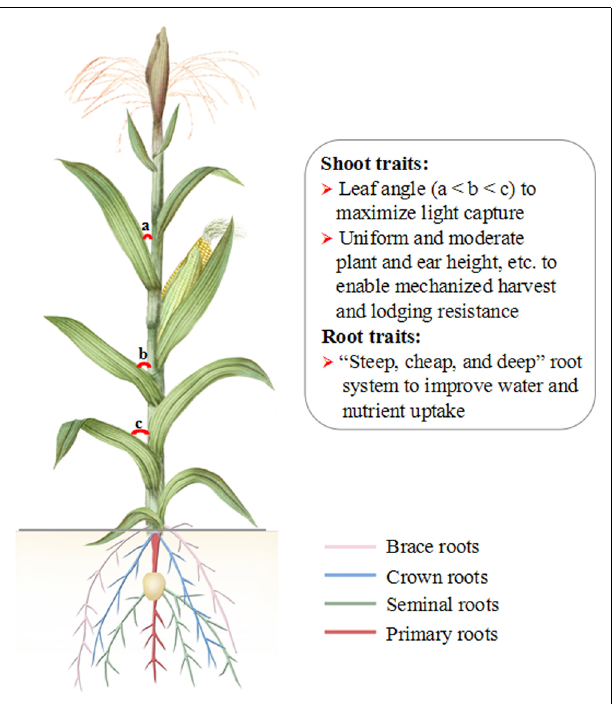
FIGURE 2 | A diagram of proposed maize ideotype. Maize ideotype plants will have improved shoot and roots traits and phenotype, enhanced stress resistance and maintain a high productivity in a changing